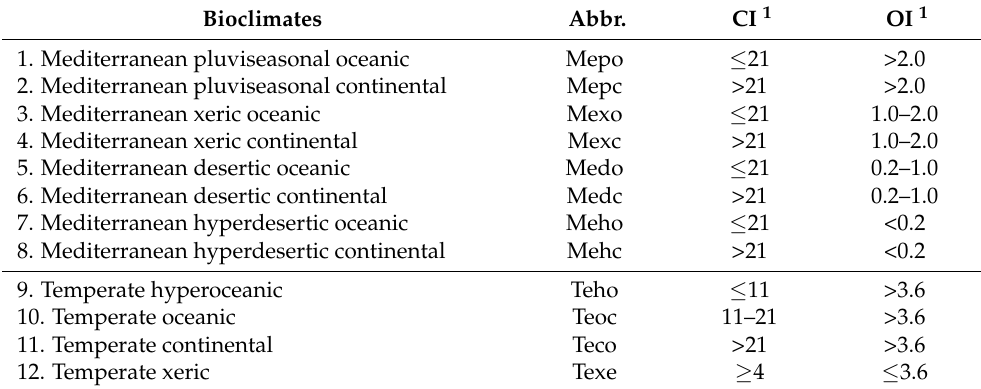
Table 1. Bioclimatic classification for Mediterranean and temperate macrobioclimates, according to Rivas-Mart í nez et al. [23] (Adapted with permission from Andrade and Contente [11]). Bioclimates Abbr. CI 1 OI